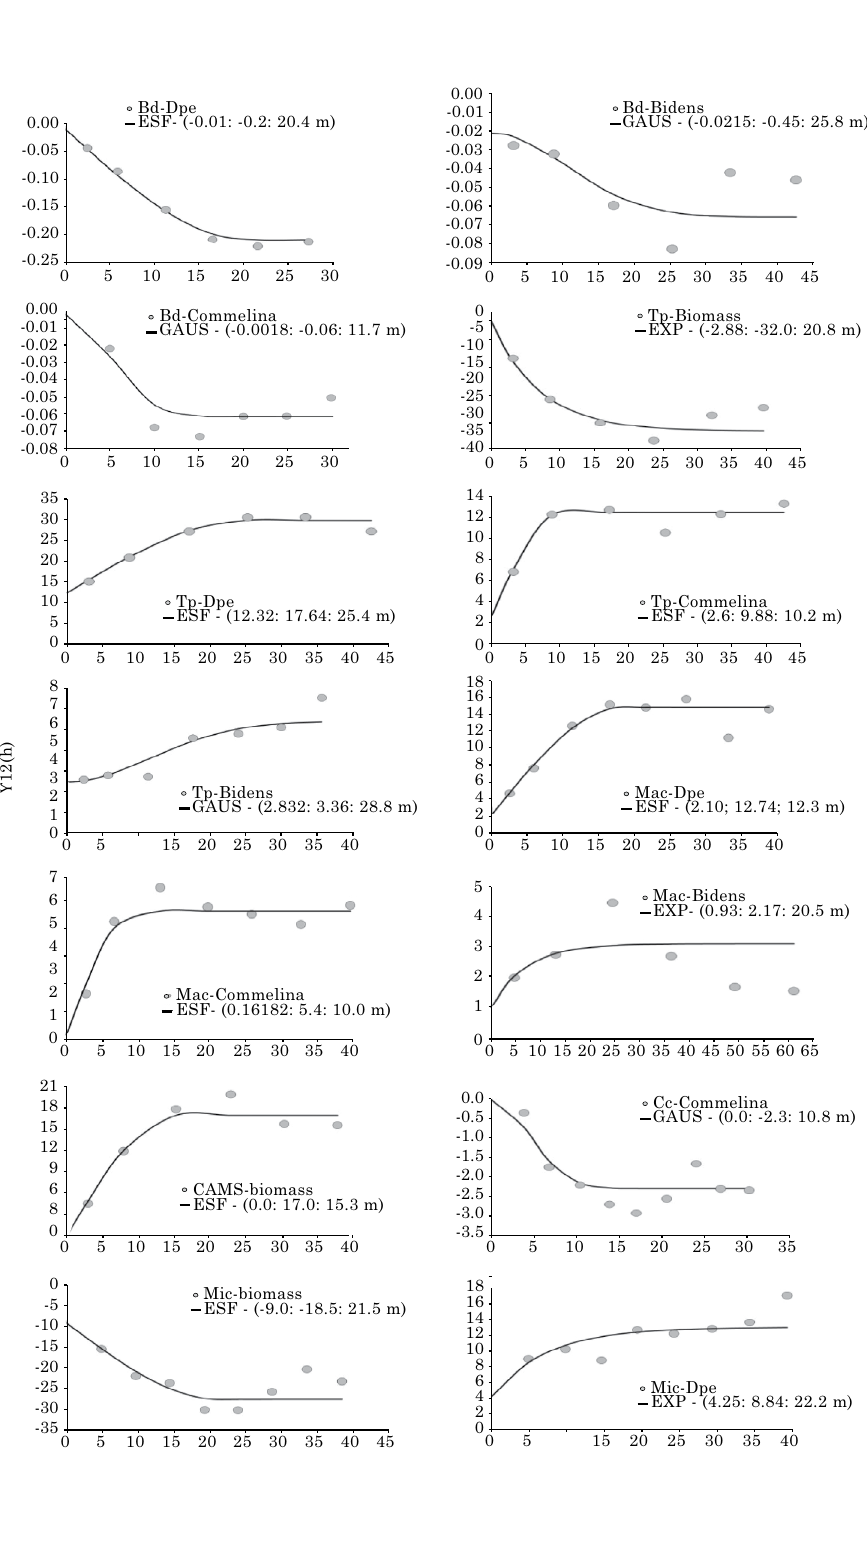
Figure 1. Cross variograms and mathematical models adjusted to weed variables and physical properties of the soil in no-tollage system. Bd: soil bulk density (kg dm -3 ); Tp: total porosity (m 3 m -3 ); Mac: macropores equivalent to the pores drained at -60 hPa tension (m 3 m -3 ); Micro: microporosity (m 3 m -3 ); CAMS: pores drained at -100 hPa tension (m 3 m -3 ); CC: estimated water content at -100 hPa tension (m 3 m -3 ); Dpe: weed density (plants m -2 ); biomass: dry matter of weed shoots (g m -2 ); commelina: density of Commelina benghalensis plants (plants m -2 ); bidens: density of Bidens pilosa plants (plants m -2